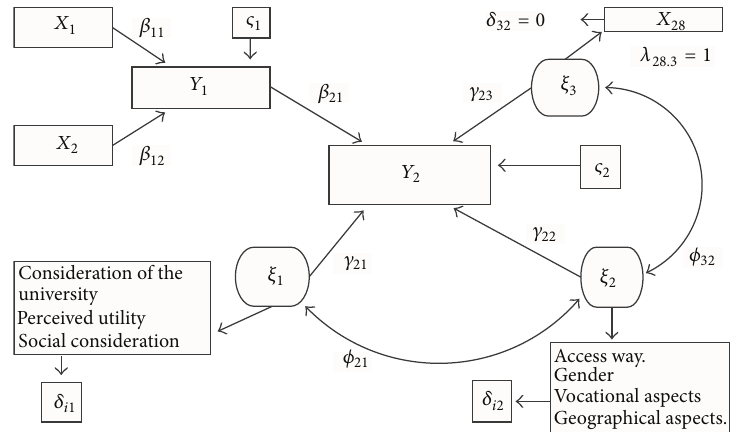
Figure 2: Specification of proposed structural model with identification of the free parameters to be